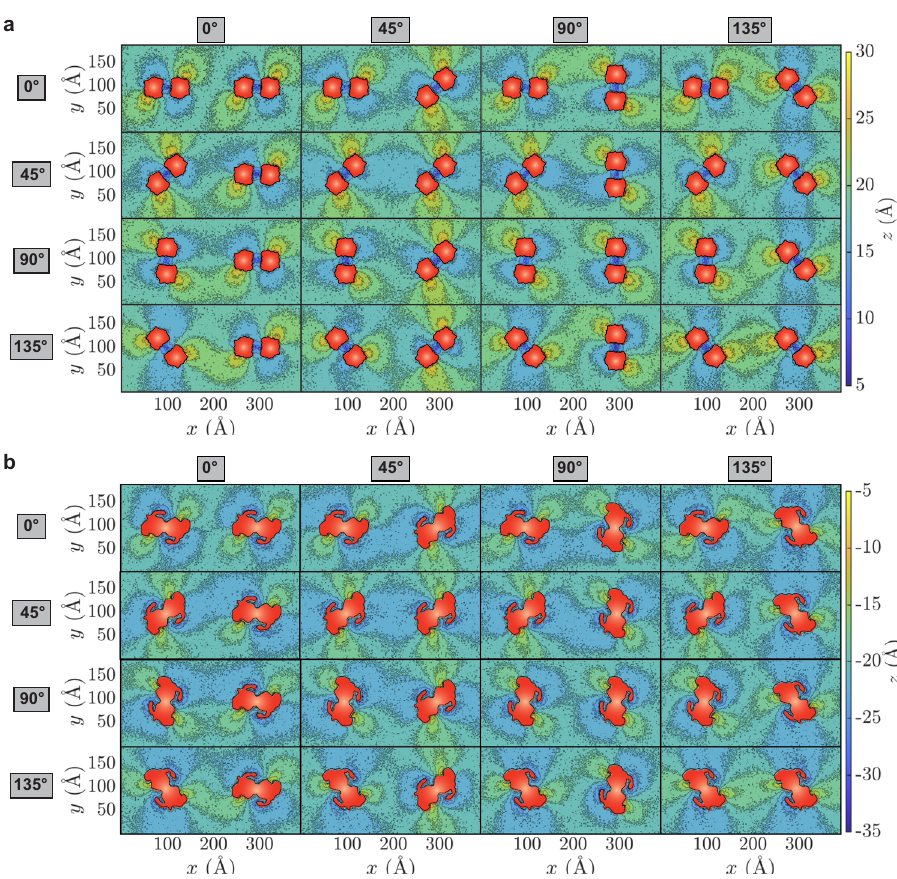
Fig. 3 | Constructive or destructive interference of deformation patterns inducedby prestin ’ s different orientations. Heatmaps of phospholipid height in the outer ( a ) and inner ( b ) lea fl ets are calculated using the procedure described in Fig. 2. The prestin dimers are placed at ( x , y )=(100,100) Å and (300,100) Å, respectively.TheorientationofDimerI(anglewithrespecttothe x axis)isspeci fi ed